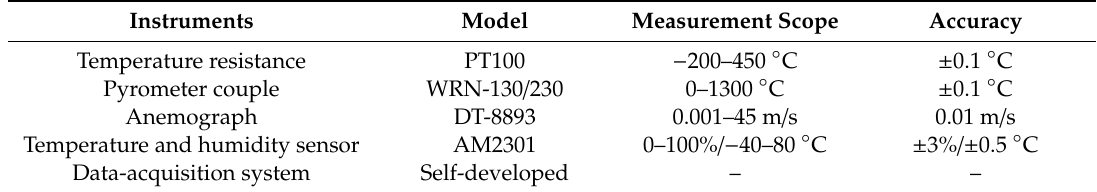
Figure 3. Thorough schematic view of the dryer and instrumentations assisted by energy and mass flow. Table 1. Descriptions of the related experimental instruments.